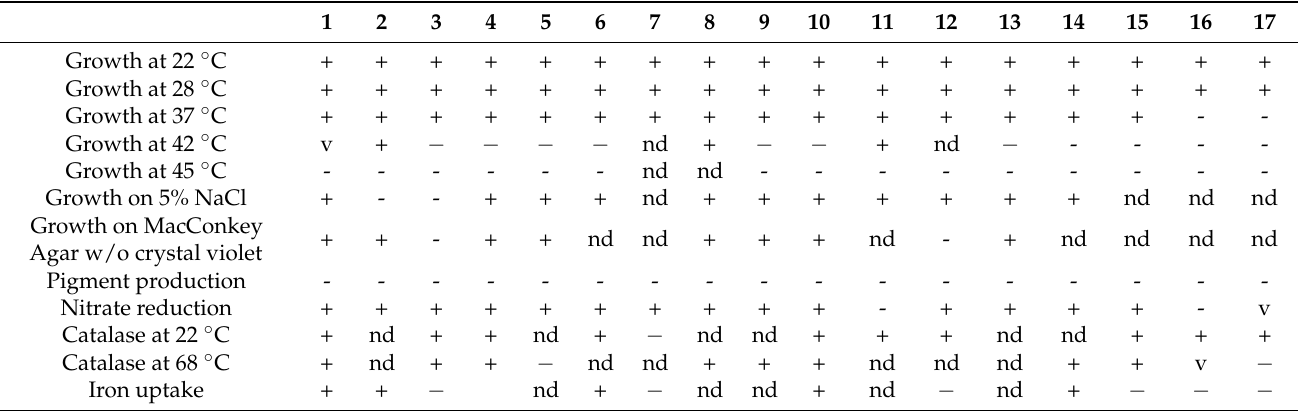
Table 1. Cultural and biochemical characteristics of the MFG members. The information about the main cultural and biochemical tests used comes from Bergey’s Manual of Systematics Bacteriology, 2nd ed. [54], with additions on the species subsequently described